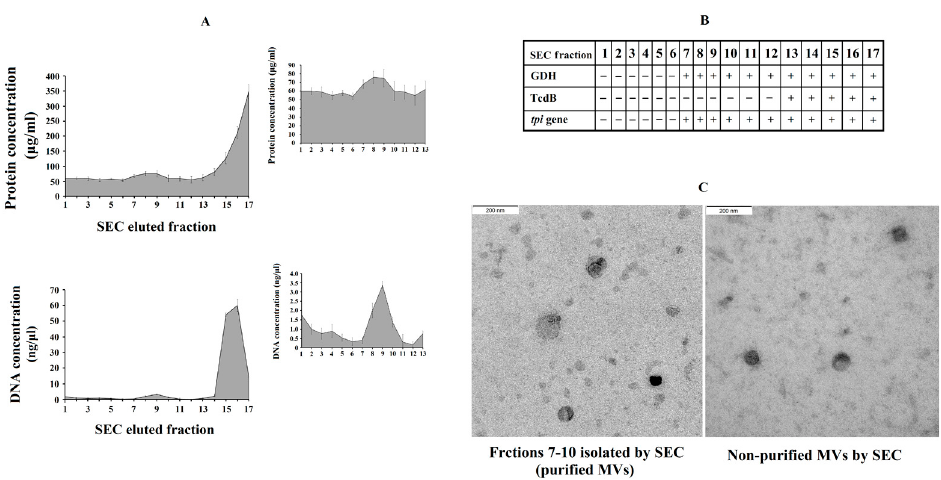
Figure 5. Analysis of C. difficile -derived MVs-rich eluted fractions after size exclusion chromatography (SEC). ( A ) Protein and total DNA concentrations of SEC eluted fractions with the magnified part of C. difficile -derived MVs-rich fractions in the upper-right corner. ( B ) Scheme showing the presence (+) or absence (-) of Glutamate Dehydrogenase Enzyme (GDH), toxin B (TcdB) and tpi gene in the SEC eluted fractions. ( C ) Characterization by electronic microscopy of the non-purified and purified (fractions 7–10) C. difficile -derived MVs. Data represent mean ± SEM ( n = 3).